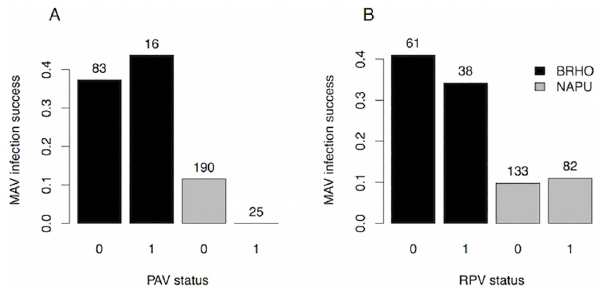
Fig 2. MAV inoculation success versus plant species and PAV (A) and RPV (B) infection status. Other plot features are the same as in Fig 1.